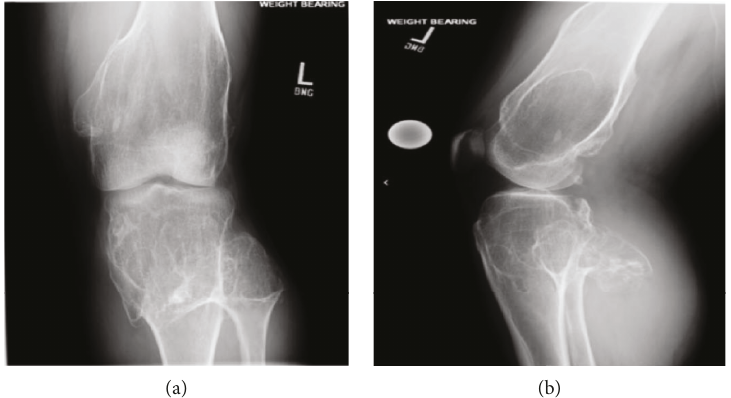
Figure 1: A preoperative anterior-posterior (AP) and lateral X-ray view of the patient ’ s left knee showing signi fi cant osteochondroma formation both superior and inferior to the knee joint. Subchondral sclerosis as well as medial and lateral loss of joint space is